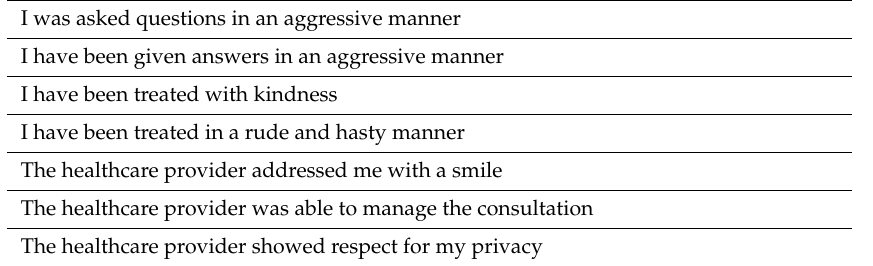
Table 1. The adapted version of the HCCQ—Health Care Communication Questionnaire [21].